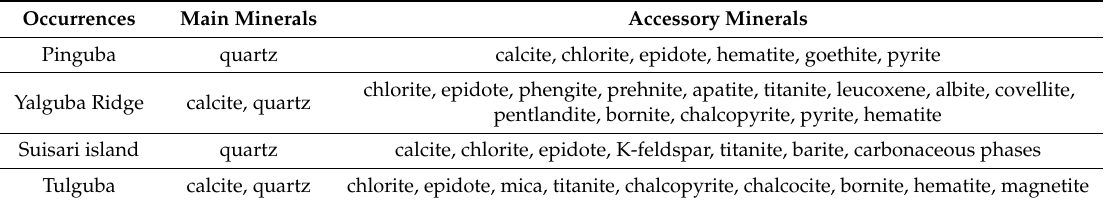
Figure 4. Macrophotographs of Onega agates: ( a ) concentrically zoned agate with green-colored chlorite pigment in the outer layer (Pinguba); ( b ) pseudostalactites of chalcedony in agate amygdule (Suisari Island); ( c ) chalcedony/calcite agate amygdale in variolitic pycrobasalt lava (Yalguba Ridge); ( d , e ) quartz/chalcedony agates with black-and-white graphic ornament (Suisari Island); ( f ) concentric zoned agate with rosy calcite and quartz crystals in the core (Tulguba); ( g ) moss agate with carbon-bearing inclusions (Suisari Island); ( h ) agate with finely dispersed hematite in core in a lava-breccia vesicle (Tulguba); ( i ) amethyst geode from basalt vesicle (Tulguba); ( j ) druse of milky quartz crystals covered Fe-hydroxide film from a fissure in basalt (Tulguba). Table 2. Mineral composition of Onega agates. Table 2. Mineral composition of Onega agates.